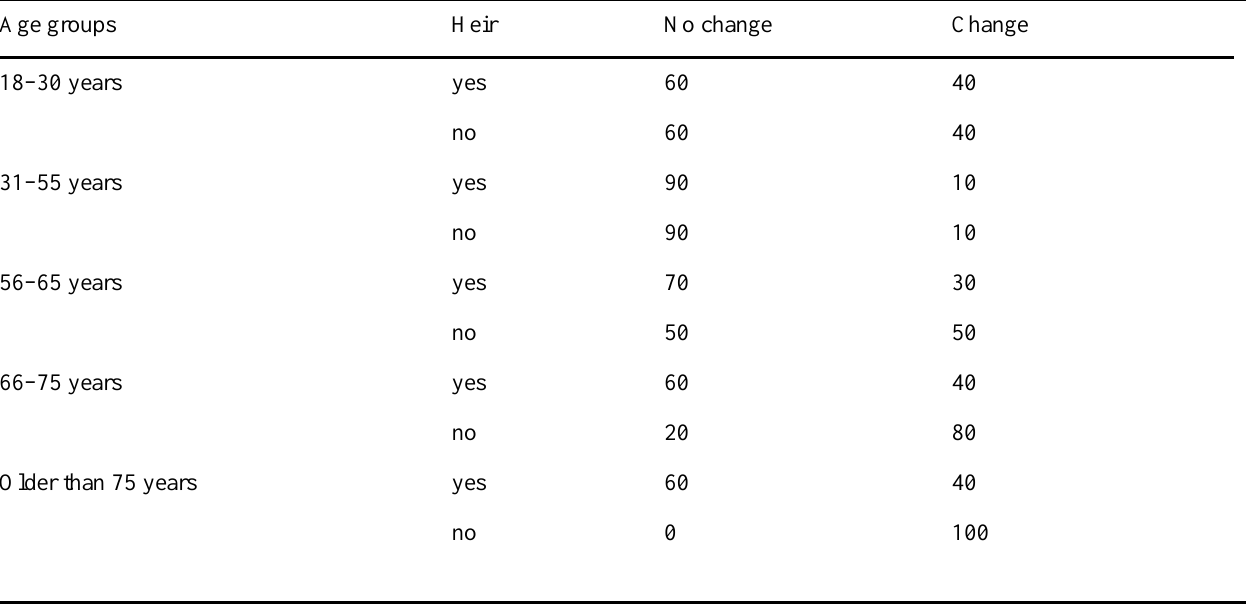
Table 4. Conditional probabilities for decision to change (Model